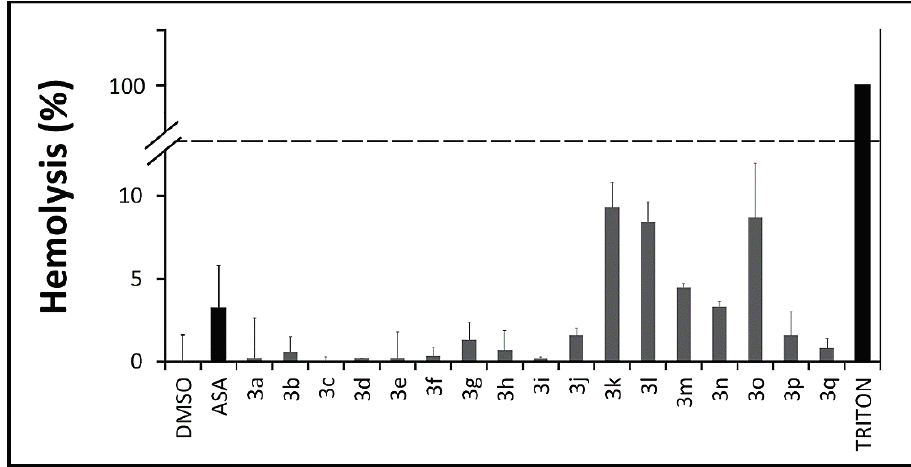
Figure 3. Evaluation of the hemolytic profile of N,N' -disubstituted thioureas through hemolysis assays over a 3 h period. Values below 10% are considered non hemolytic. All derivatives and ASA at 100 μ M; DMSO and TRITON at